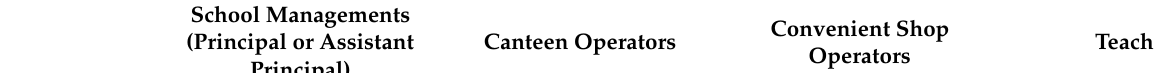
Table 2. Acceptability, Challenges and Barriers Towards Healthy Eating at School (Intervention Arms 1 and 2